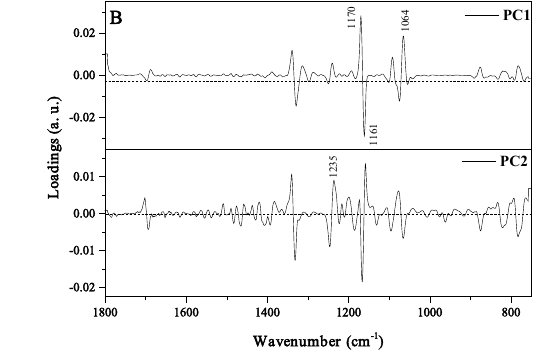
Figure 3. Principal component analysis (PCA) two-dimensional (2D) score plot (PC1 versus PC2) calculated for the data acquired from the FTIR spectra in the range between 1800—750 cm − 1 . ( A )—